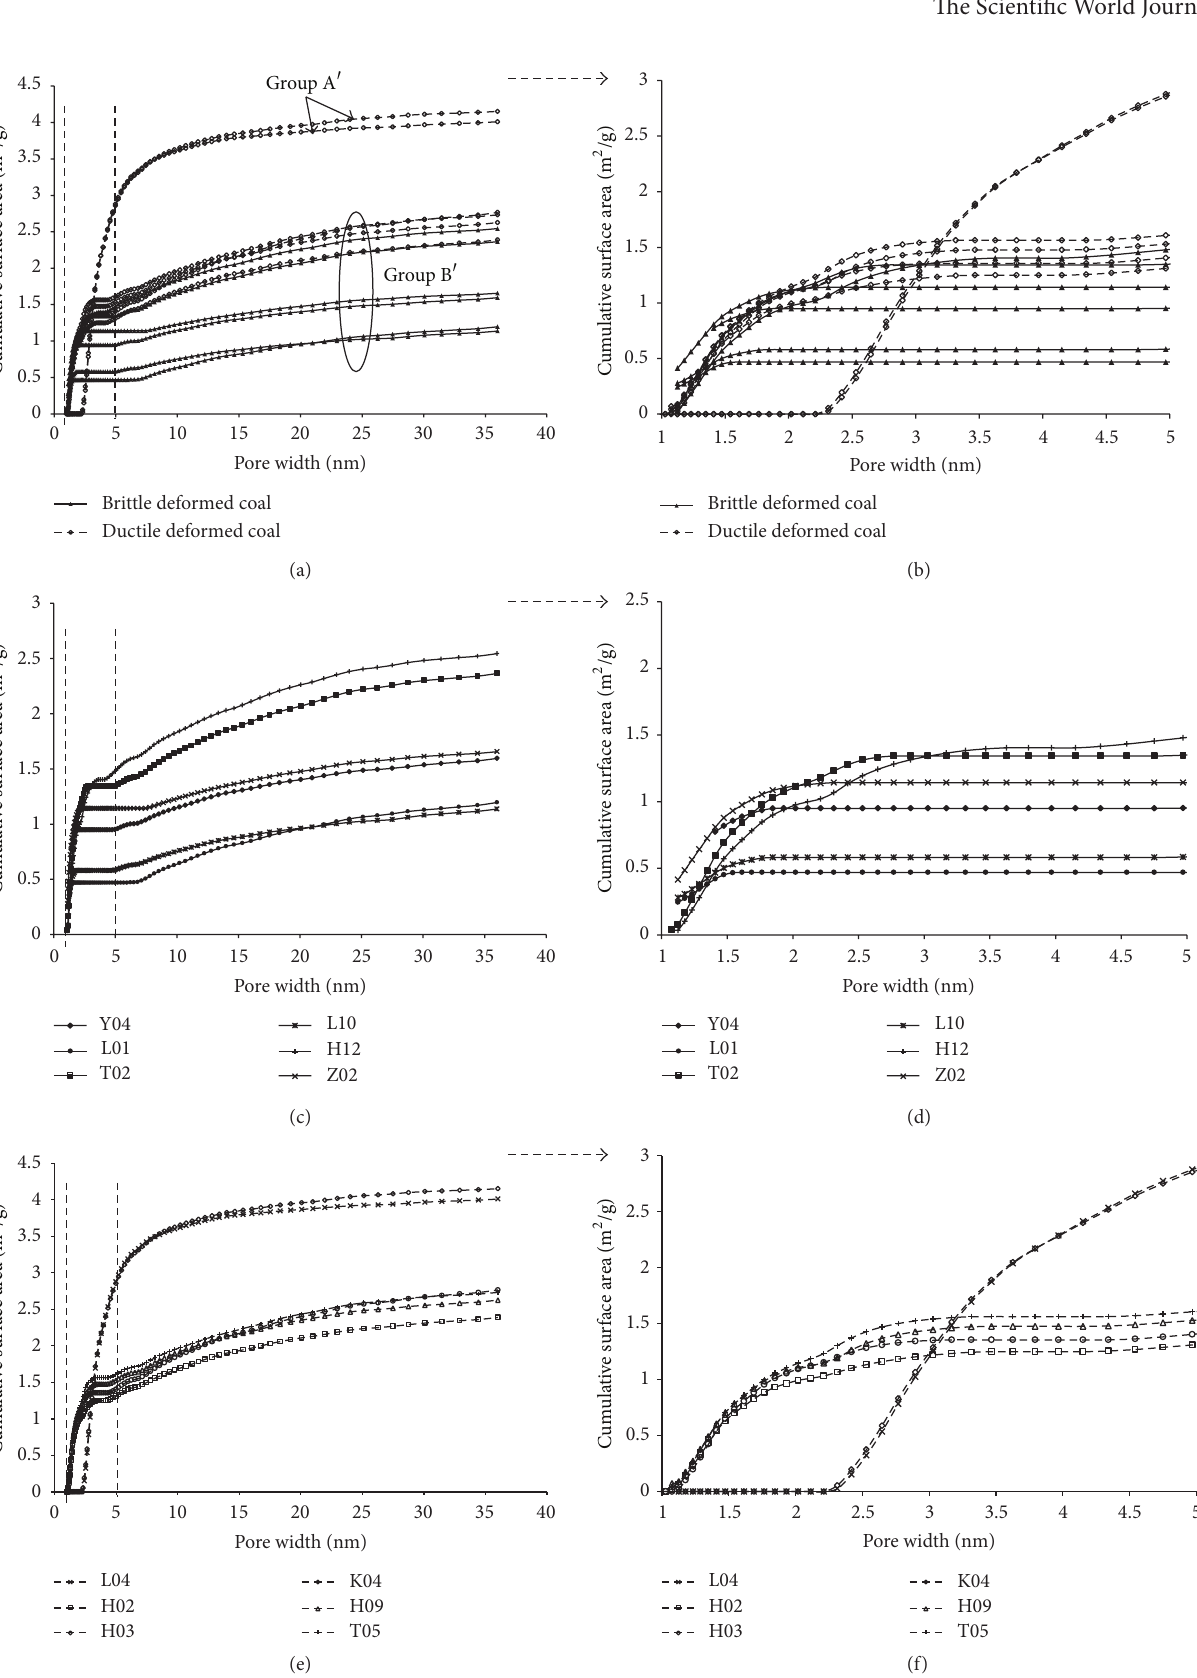
Figure 6: Relationship between cumulative surface area and pore width of deformed coal (a-b); (c, d) brittle deformed coal; (e, f) ductile deformed